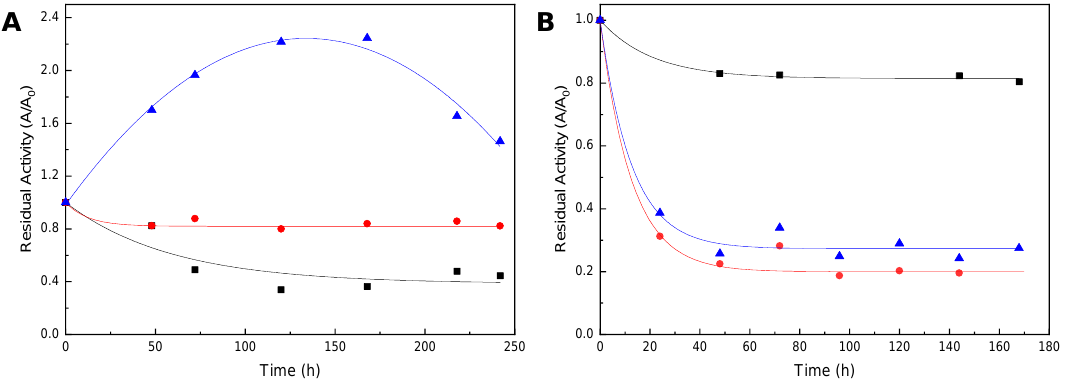
Figure 1. Stability of biocatalysts in organic solvents under non-reactive conditions at 45 °C. ( a ) Lipase from P. stutzeri immobilized in octyl-silica; ( b ) Novozym 435. Acetonitrile (blue triangles), acetone (red circles) and 2M2B (black squares).